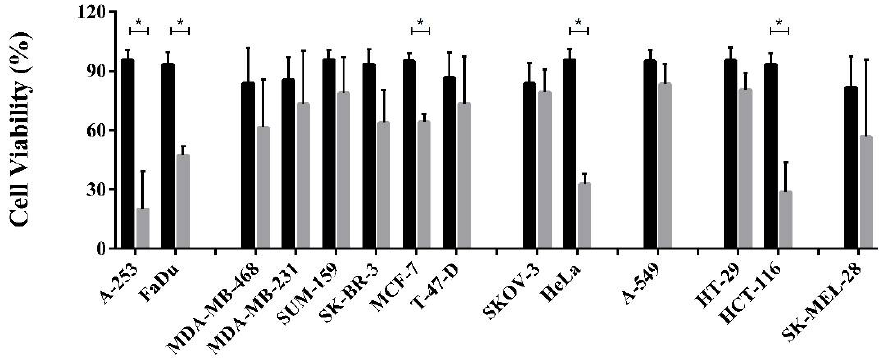
Figure 5. Cell viability assay. Reported cancer cell lines were incubated for 48 h in the presence of ACN (black bars) and 100 μM DM (gray bars) in an incubator at 37 °C, 5% CO 2 . Following the 48 h, the cells were stained with MTT and incubated for 4 h. Cell viability was recorded by measuring the OD at 590 nm. The figure shows the cumulative data of three independent experiments with mean ± SD value. Asterisk indicates * p ≤ 0.05.